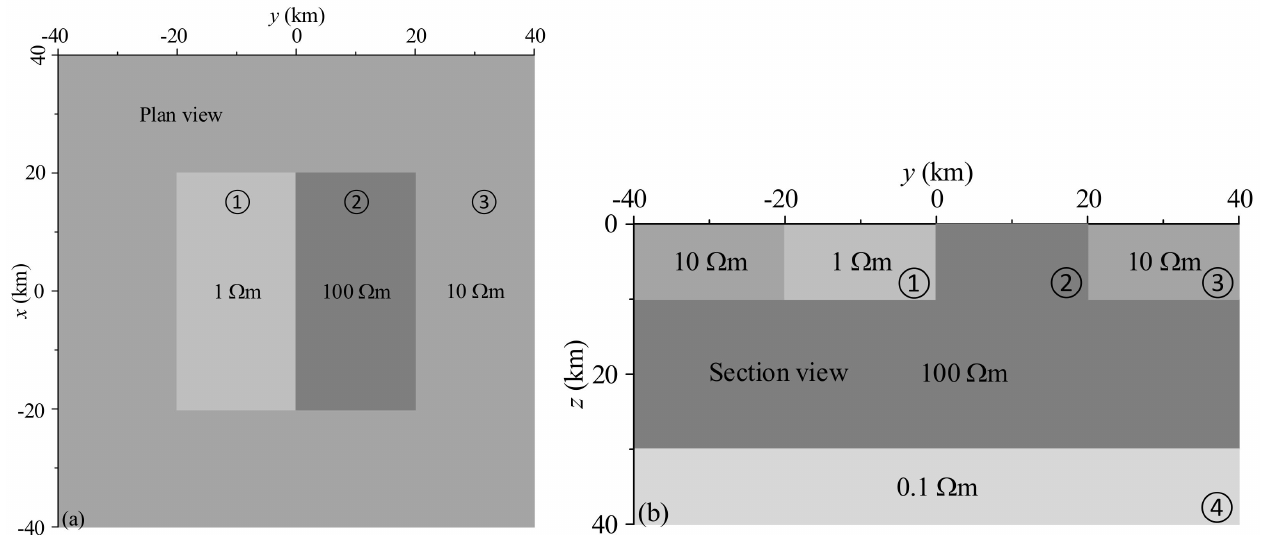
Figure 14. COMMEMI 3D-2A model. ( a ) The planar view, looking from negative to positive in the z-direction. ( b ) The section view, looking from negative to positive in the x-direction. The number from 1 (cid:13) − 4 (cid:13) denote the media with different